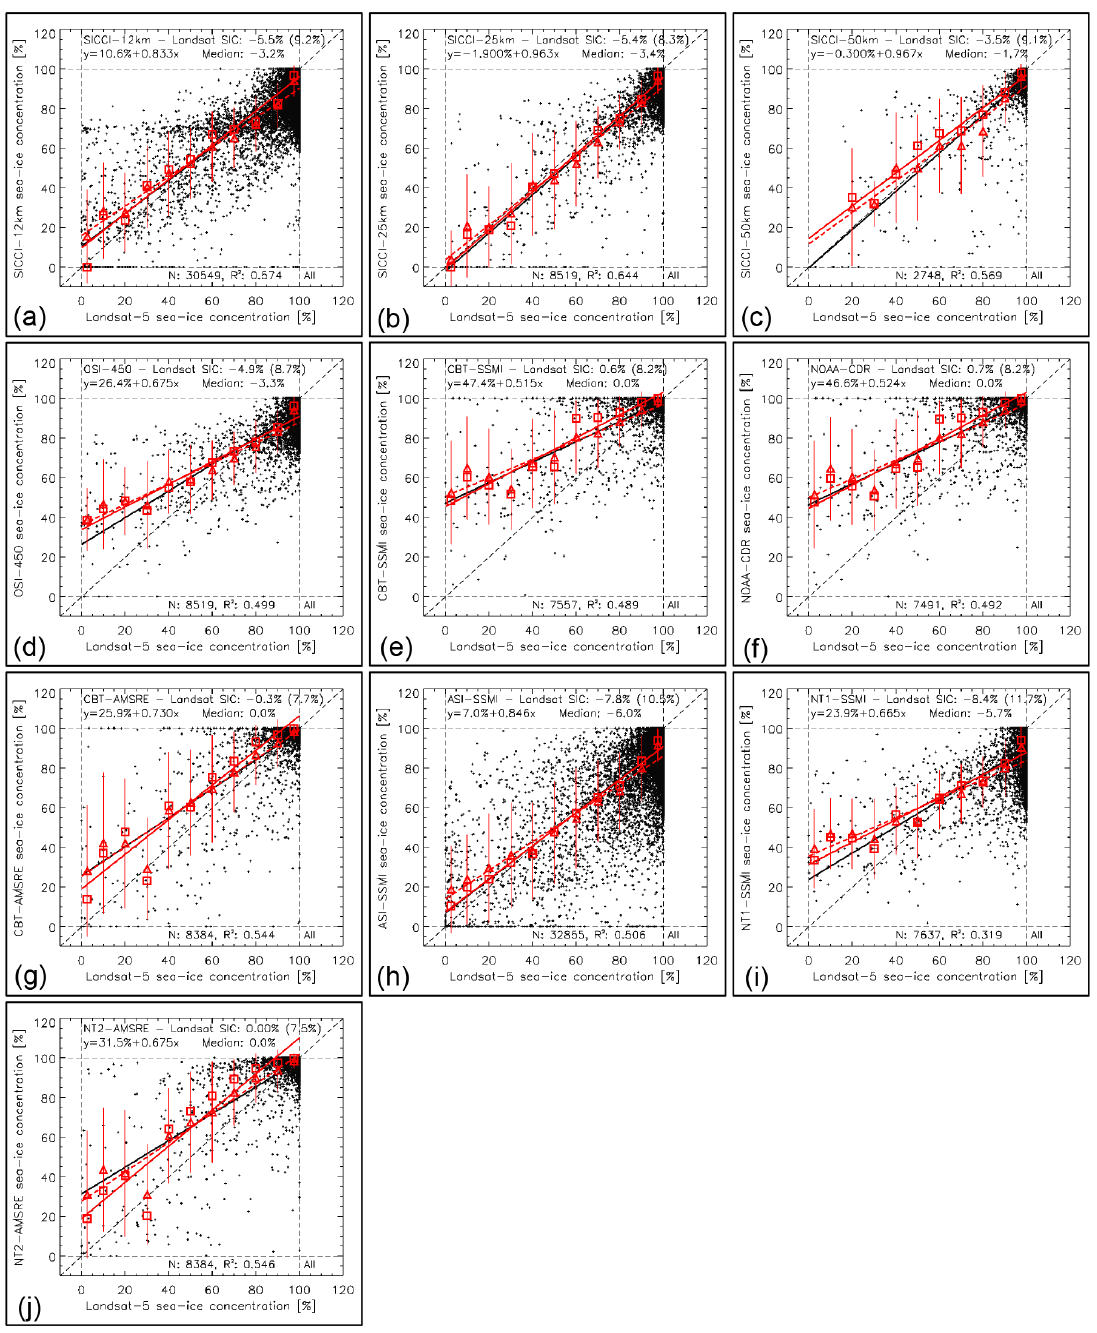
Figure 2. Scatterplots of PMW SIC ( y axis) versus Landsat SIC ( x axis) for all 10 products for the first-year-ice-dominated cases from 2003–2011 in the Northern Hemisphere (Landsat-5). Black dots are individual data pairs, the solid black line is the linear regression, and the dashed black line is the identity line. Red triangles denote the mean PMW SIC computed for Landsat SIC ranges 0%–5%, 5%–15%, 15%–25%, ... , 85%–95%, 95%–100%, red bars denote 1 standard deviation of these mean values, and the dashed red line is the respective linear regression line. Red squares denote the median PMW SIC for the same Landsat SIC ranges, and the solid red line is the respective linear regression line. The overall mean and median difference PMW SIC minus Landsat SIC, its standard deviation, and the equation of the linear regression through the individual data pairs are shown at the top and the number N of data pairs and the squared linear correlation coefficient at the bottom of each